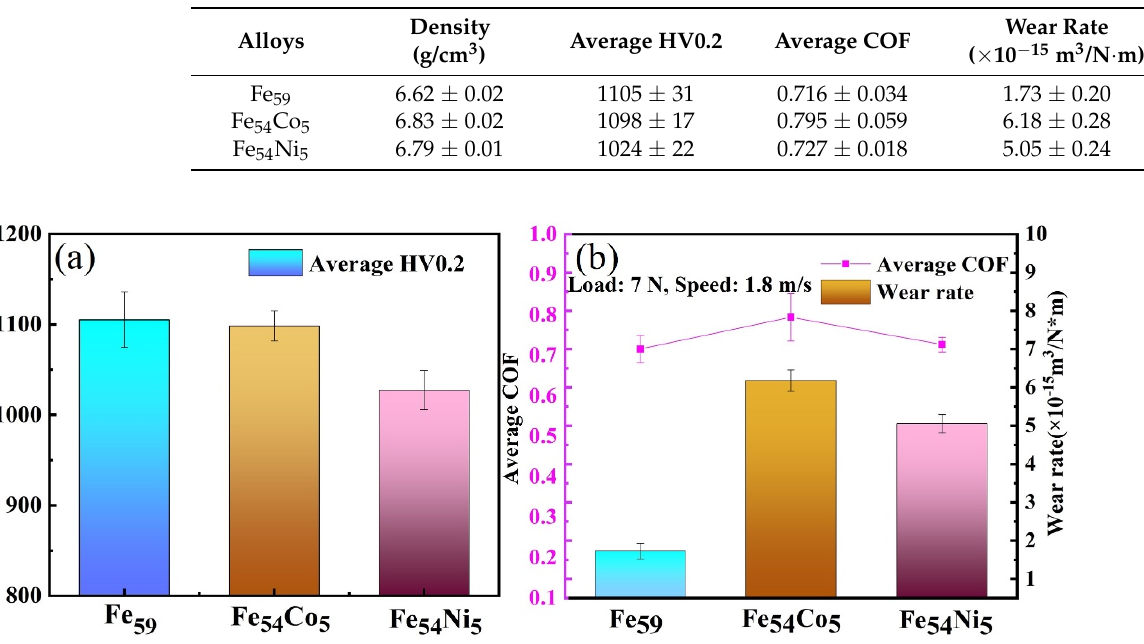
Figure 5. ( a ) Microhardness, ( b ) average coefficient of friction (COF), and wear rate of the Fe 54 M 5 Cr 15 Mo 6 Si 2 B 4 P 10 C 4 (M = Fe, Ni, and Co) BMGs.